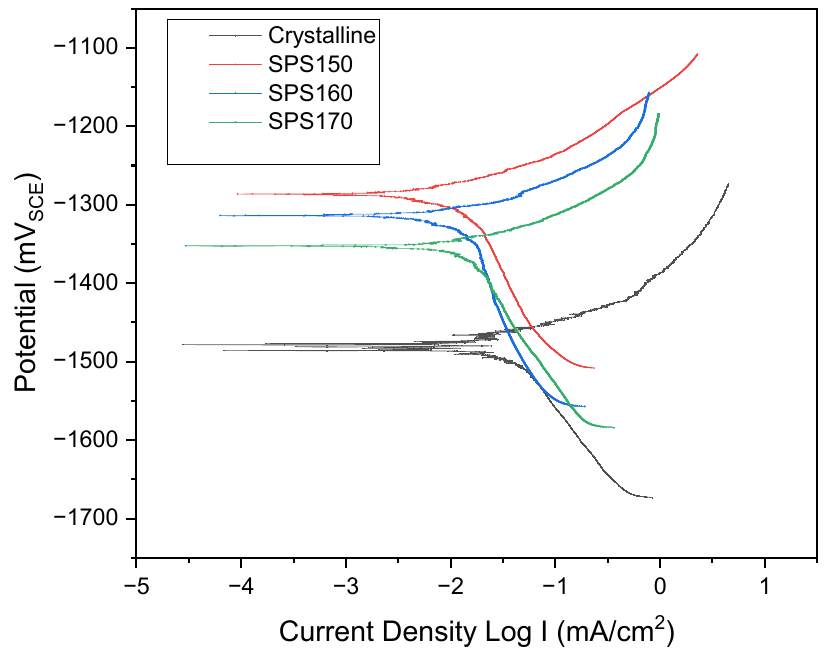
Figure 8. Potentiodynamic plot of Mg-Zn-Ca across various sintering temperatures compared to as- cast.